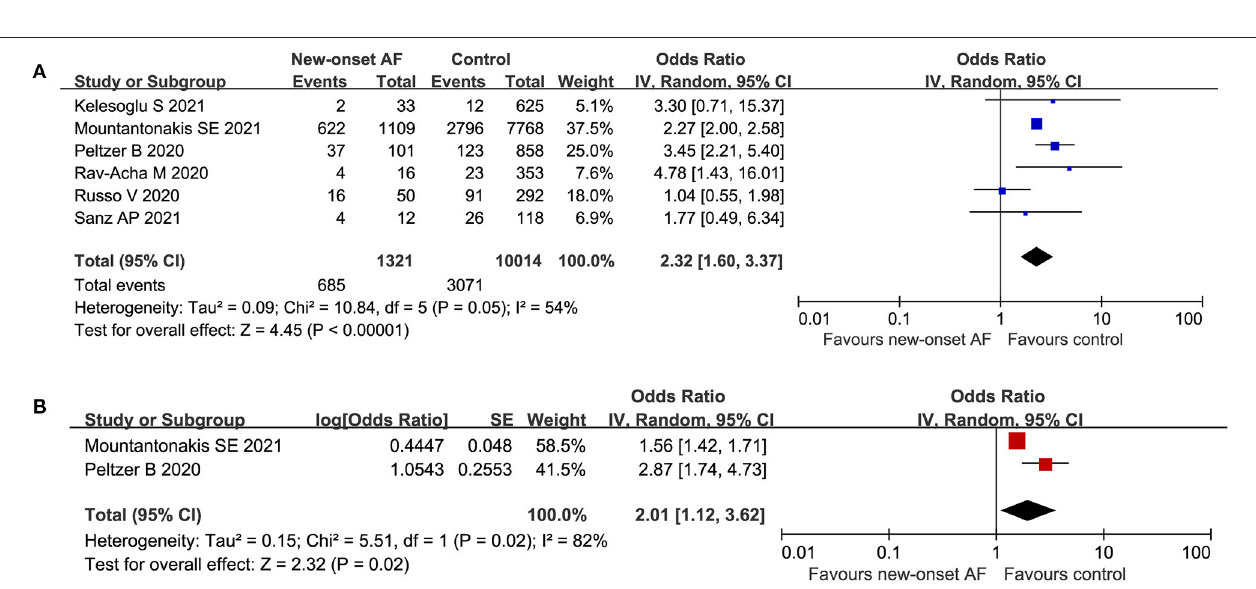
FIGURE 4 | Forest plot of the association between atrial fibrillation and all-cause mortality in patients with COVID-19. (A) Crude effect size of the association between atrial fibrillation and all-cause mortality in patients with COVID-19. (B). Adjusted effect size of the association between atrial fibrillation and all-cause mortality in patients with COVID-19.